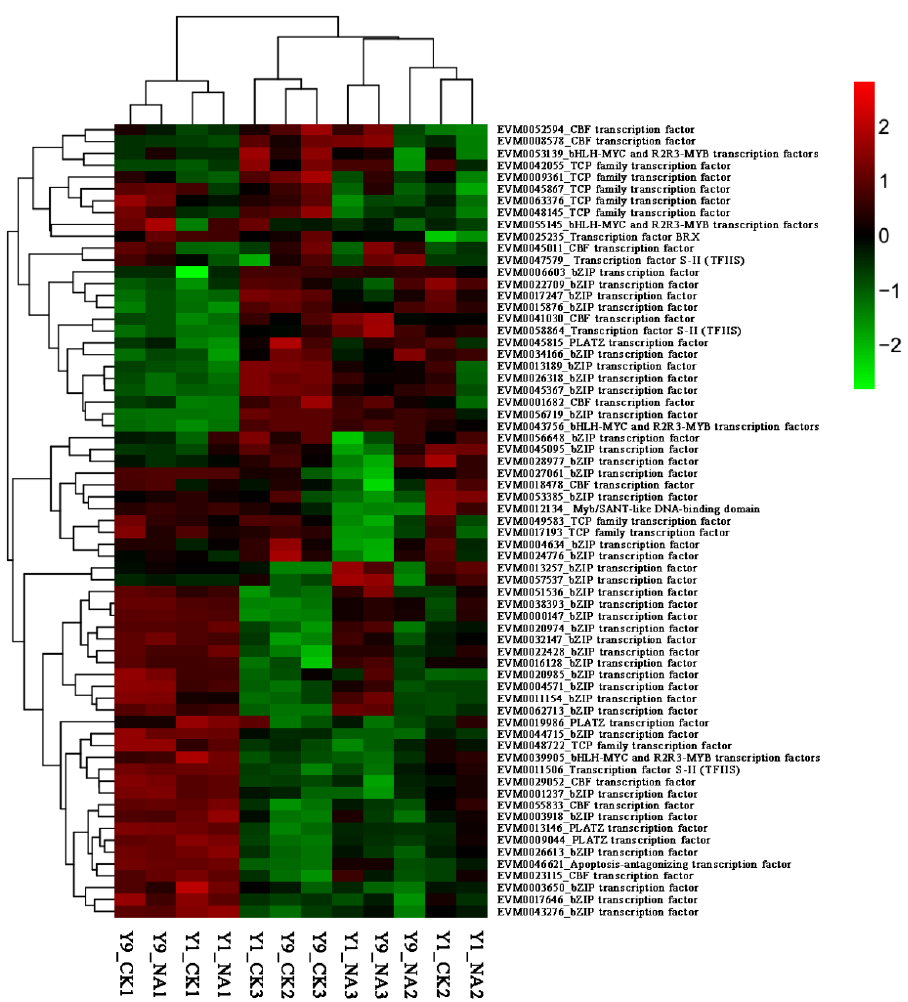
Figure 4. Heatmap of TFs involved in seed germination under salt stress. Heatmap of TFs were clustered by columns. Y9, Y1 represent Yumi 9 and Yumi 1, respectively. CK represents control, NA represents salt stress (250 mM NaCl). 1, 2, 3 represent the three periods. Y9_CK1 refers to Yumi 9 germination under RO water in the first period. The treatments and varieties are similarly indicated in the remaining labels. The information on the righthand side of the heatmap corresponds to the gene ID and annotation.